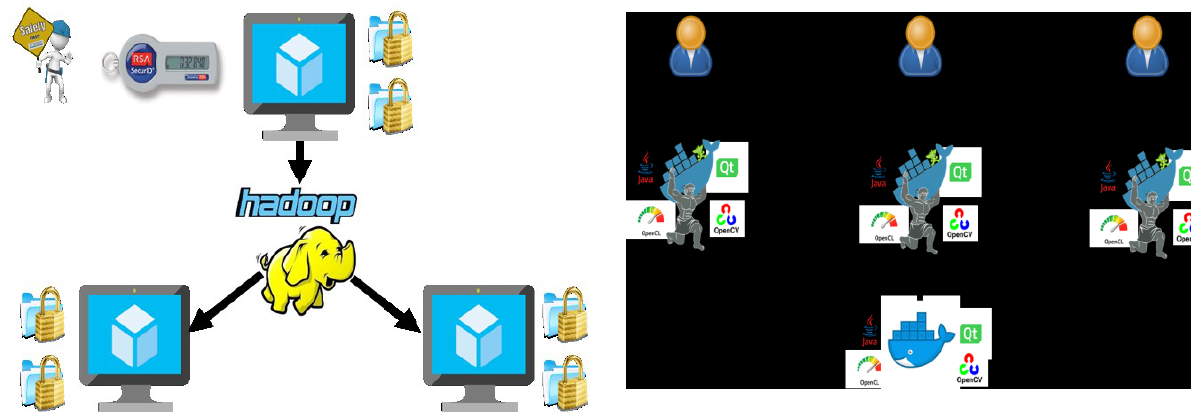
Figure 2 | Data encryption of our platform. Figure 3 | Architecture of our cloud-based